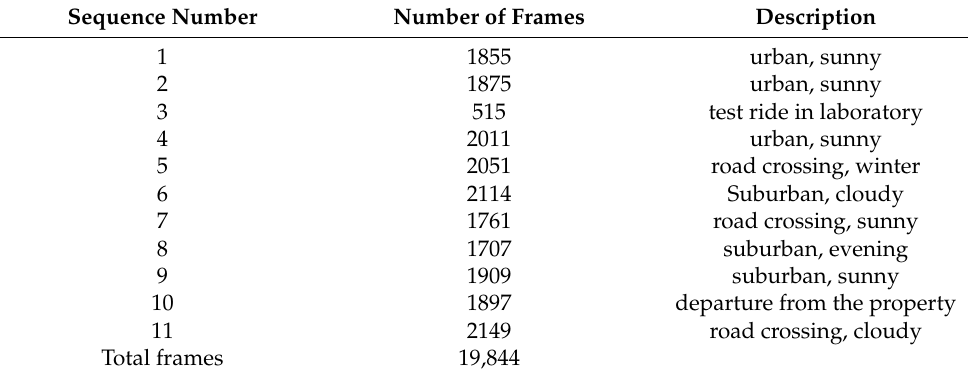
Table 1. Description of tested video sequences of RCCC